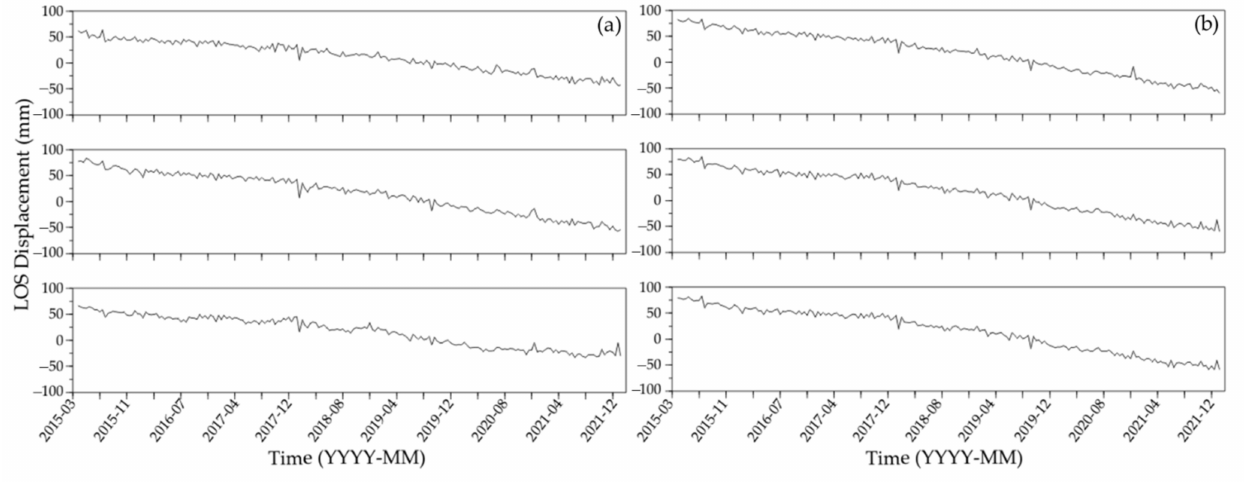
Figure 7. Example of time-series grouped in the same family with CAPS using two different thresh- olds: ( a ) 0.83 and ( b ) 0.95. Time-series in ( a ) are less similar to each other than those in ( b ) due to the lower